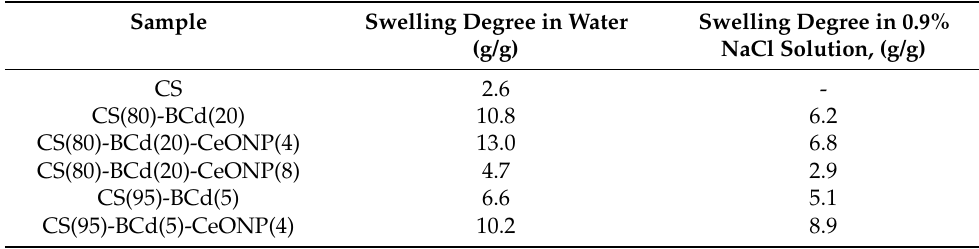
Table 1. The swelling degree of the CS and composite